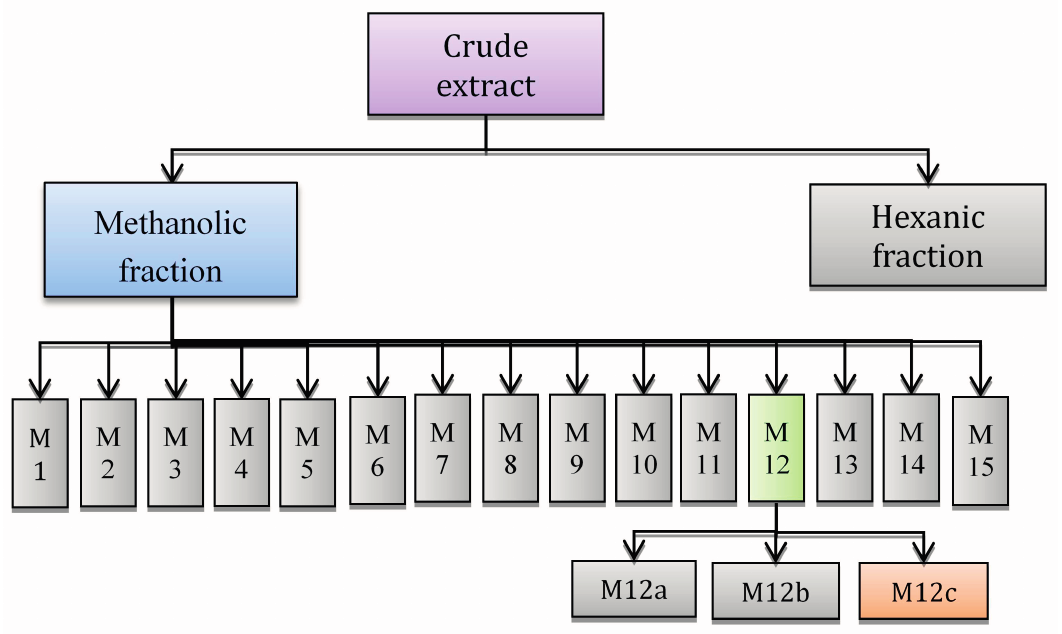
Figure 9. Schematic for separation and isolation of antiproliferative fractions from